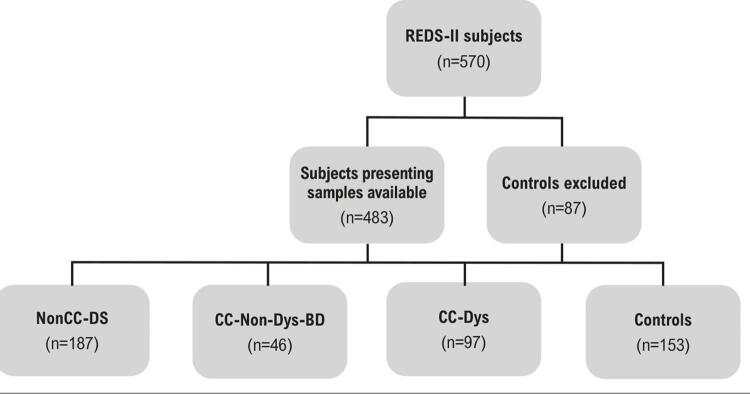
– Flowchart of inclusion.